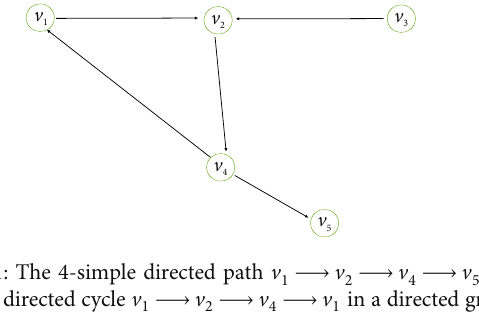
Figure 1: The 4-simple directed path v 3-simple directed cycle v 1 ⟶ v 2 ⟶ v 4 ⟶ v 1 in a directed